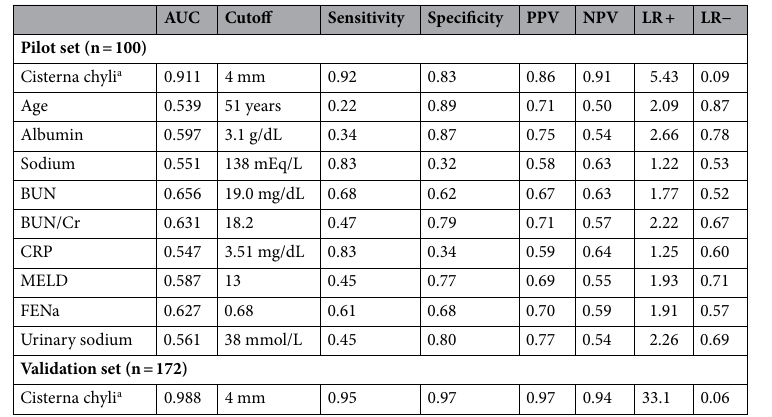
Table 3. Diagnostic accuracy for the effect of tolvaptan. AUC area under the curve, PPV positive predictive value, NPV negative predictive value, LR + positive likelihood ratio, LR − negative likelihood ratio, BUN blood urea nitrogen, BUN/Cr blood urea nitrogen/creatinine, CRP c-reactive protein, MELD model for end-stage liver disease, FENa fractional excretion of sodium. a The cisterna chyli diameter.